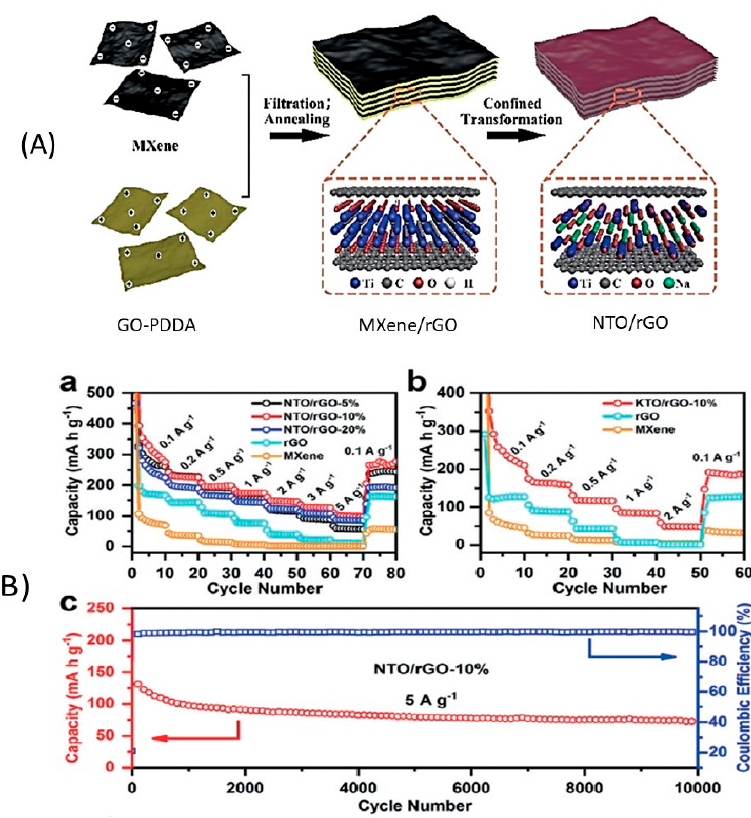
Figure 9. ( A ) Synthesis of free-standing films of sodium titanate nanosheets (NTO) sandwiched between graphene layers from MX ene (titanium carbide) and reduced graphene oxide (rGO) nanosheets. ( B ) Electrochemical performance of the NTO/rGO films for SIBs. ( a ) Comparison of rate performance of NTO with different rGO content, rGO and MX ene at various current densities. ( b ) Comparison of rate performance of KTO/rGO-10 %, rGO and MX ene at various current densities. ( c ) Long-term cycling discharge capacities and Coulombic efficiencies of NTO/rGO-10 % at 5 A g − 1 . Reproduced with permission from [245]. Copyright 2016 Elsevier.